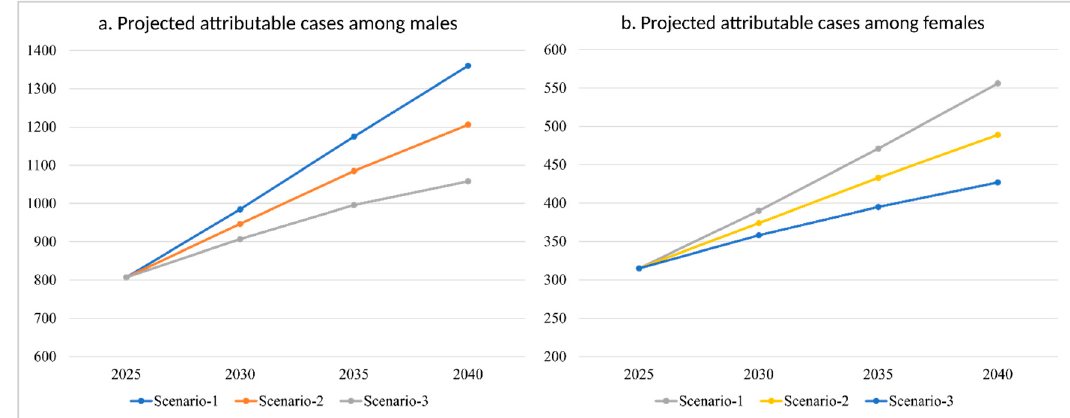
Figure 3. Projections of combined attributable CRC cases under different scenarios for ( a ) males and ( b ) females in Saudi Arabia, 2025–2040.